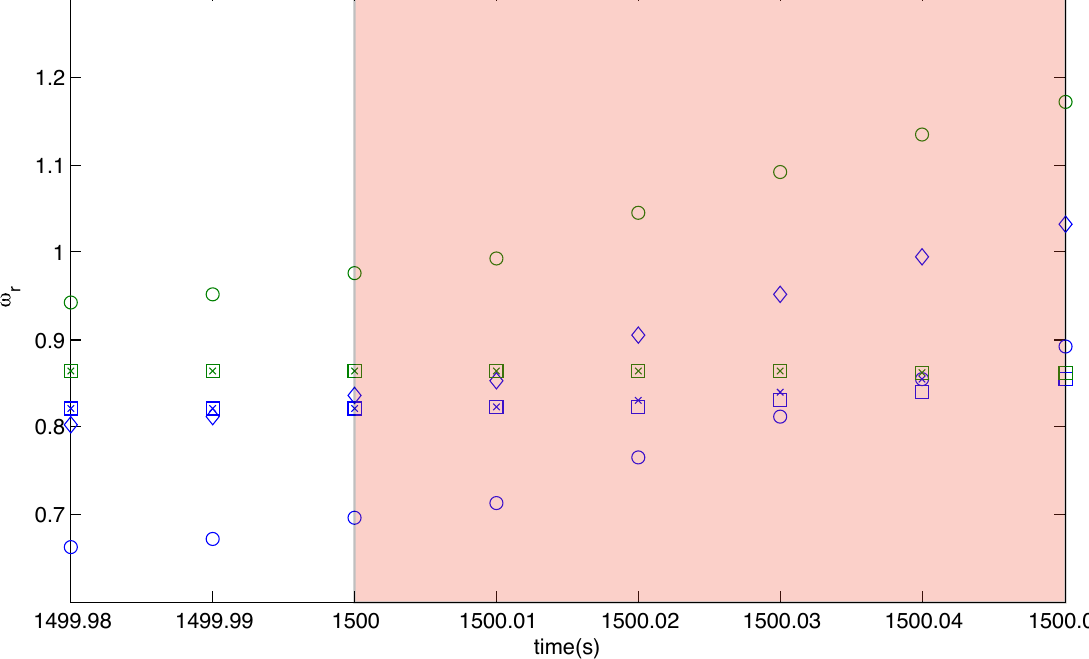
( k ) , ◦ : [ ω ( k )] y , r , m 1 r , m 1 ( k )] p and r , m 1